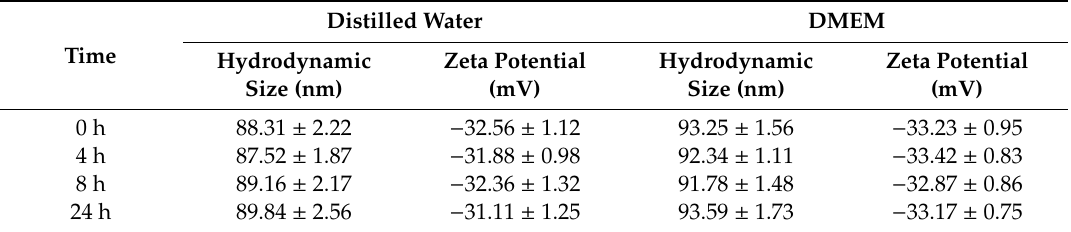
Table 1. Hydrodynamic size and zeta potential measurement of nSiO 2 in distilled water and culture medium.